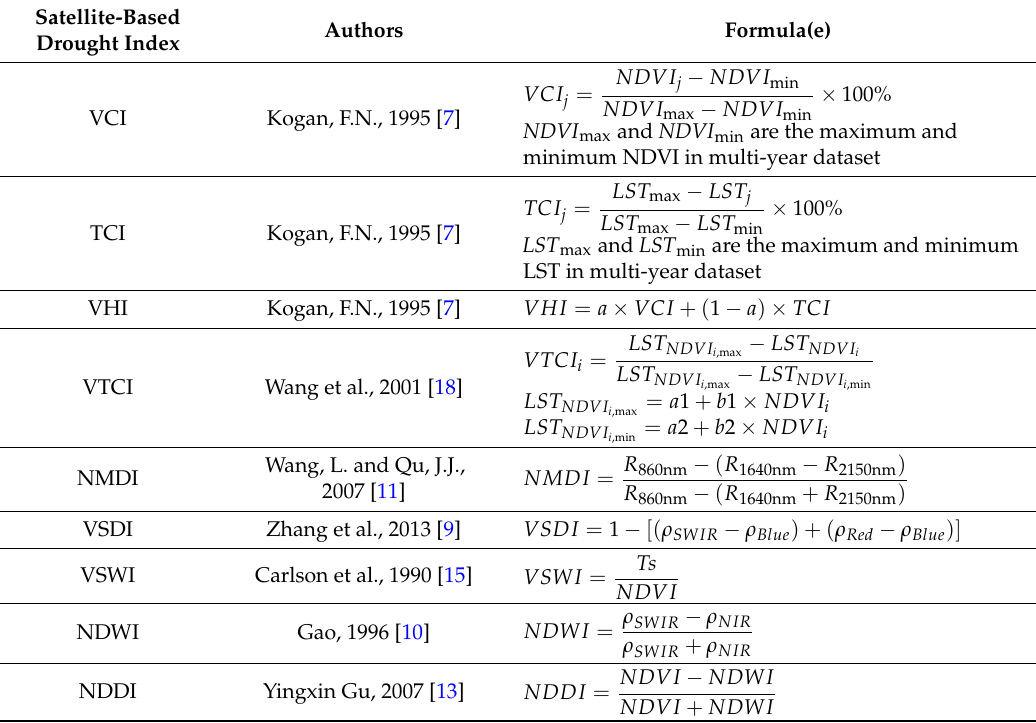
Table 2. Candidate drought